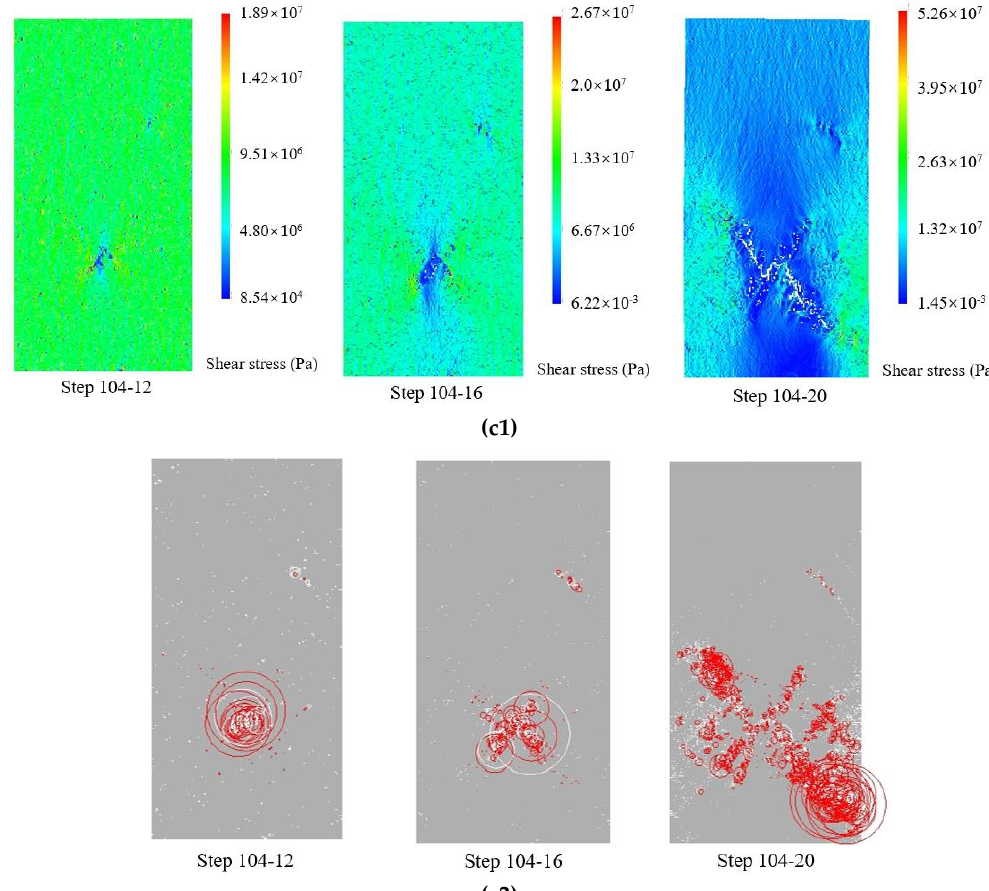
Figure 10. Development of fractures in coal samples under triaxial compression. ( a1 ) The maximum shear stress distribution of the coal sample at σ = 2 MPa; ( a2 ) acoustic emission of the coal sample at σ = 2 MPa; ( b1 ) the maximum shear stress distribution of the coal sample at σ = 3 MPa; ( b2 ) acoustic emission of the coal sample at σ = 3 MPa; ( c1 ) the maximum shear stress distribution of the coal sample at σ = 4 MPa; ( c2 ) acoustic emission of the coal sample at σ = 4